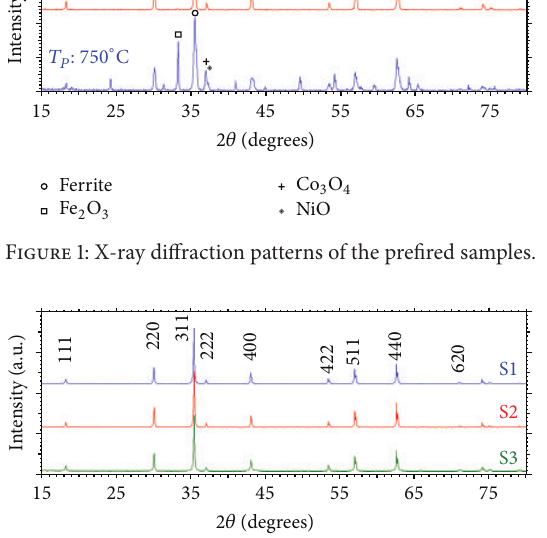
Figure 2: X-ray diffraction patterns of the sintered